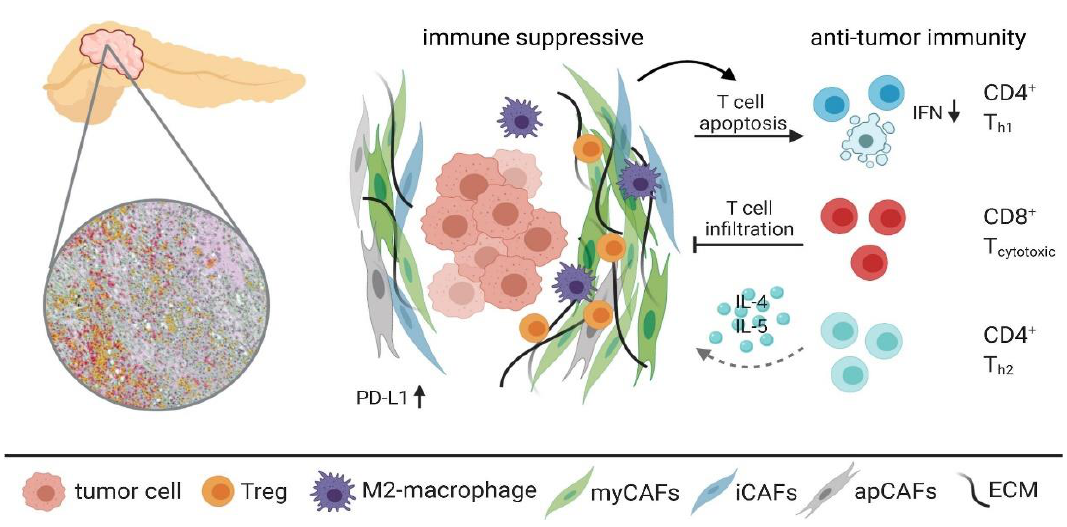
Figure 1. Immune infiltrates of pancreatic ductal adenocarcinoma form an immune suppressive environment. Anti-tumor immunity is suppressed through T-cell apoptosis, inhibition of cytotoxic T-cell recruitment and reduced secretion of pro-inflammatory cytokines, such as IL-4 and IL-5. PD-L1: Programmed death-ligand 1, Treg: regulatory T-cell, myCAFs: myofibroblastic cancer-associated fibroblast (CAF), iCAFs: inflammatory CAFs, apCAFs: antigen-presenting CAFs. Created with BioRender.com.